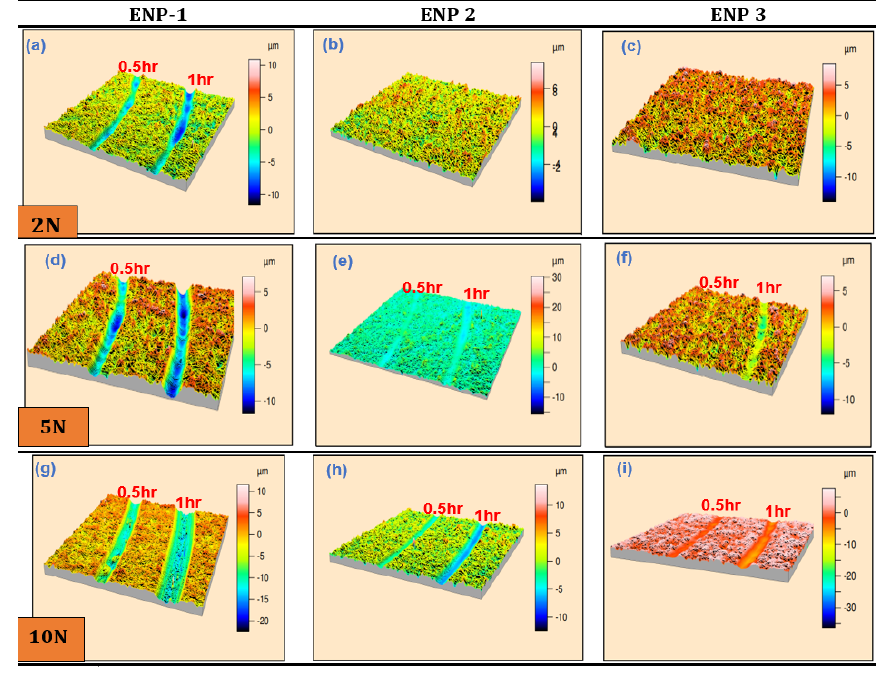
Figure 12. 3D optical profilometry images of the worn tracks on the developed ENP+PTFE: ENP1, ENP2 and ENP3 duplex coatings at various loads and sliding cycles.